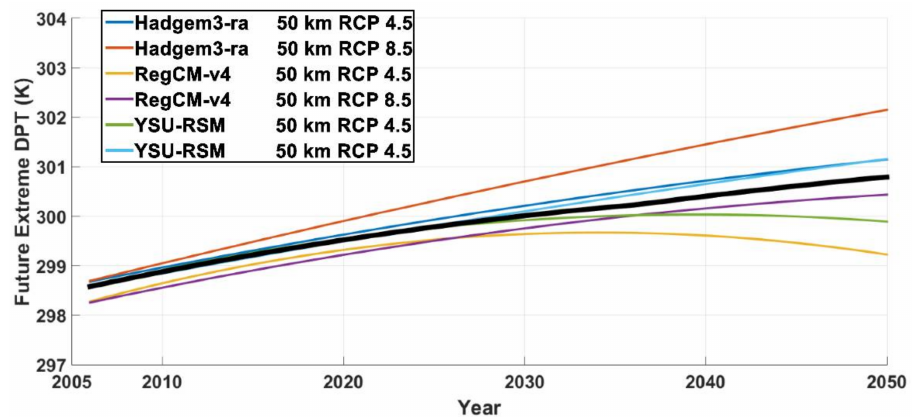
Figure 8. Trend of future extreme dew-point temperature for return period of 100-year and persistence interval of 12-h at Seoul station in the first half of